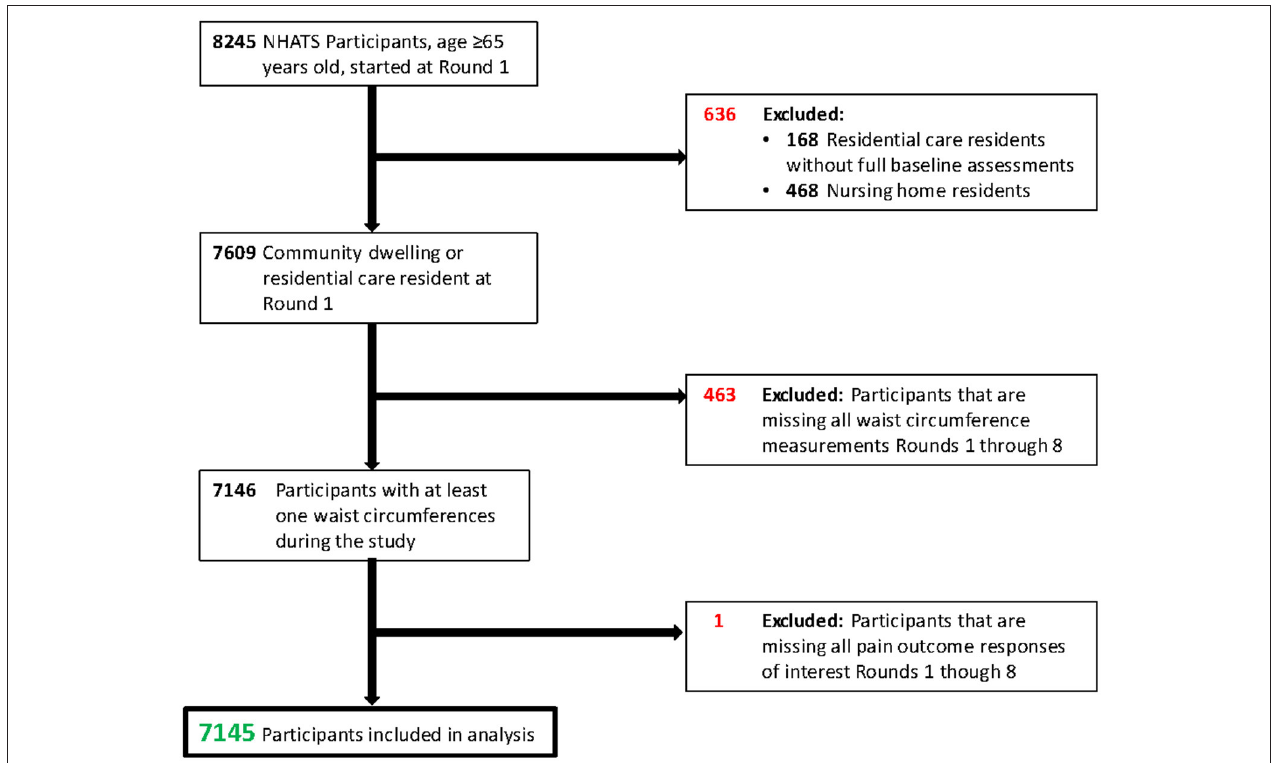
FIGURE 1 | Population flow